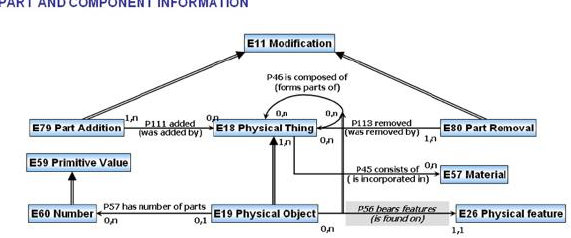
Figure 4. Conceptual representation of the part and component information according to the CIDOC-CRM (image from http://www.cidoc-crm.org/FunctionalUnits/part-and-